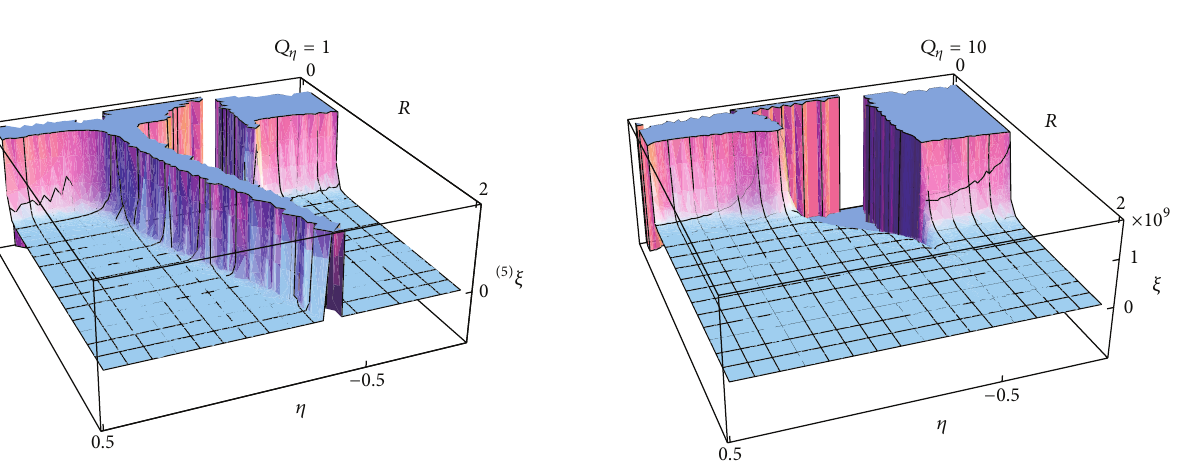
Figure 14: 5D Kretschmann invariant (5) 𝜉 for 𝑄 𝜂 = 10 , for Λ = 0